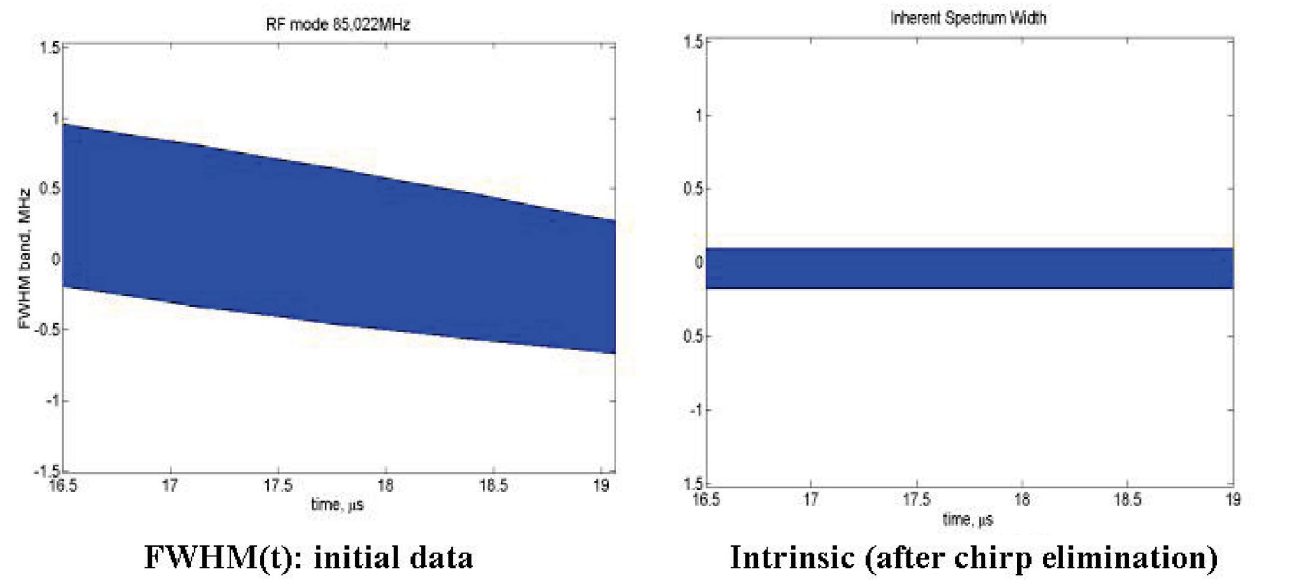
FIG. 8. (Color) Spectral FWHM of a rf mode. Local oscillator frequency is 85 022 MHz. Left: initial data; right: after the digital chirp elimination. Time window is 1 and 10 (cid:1) s